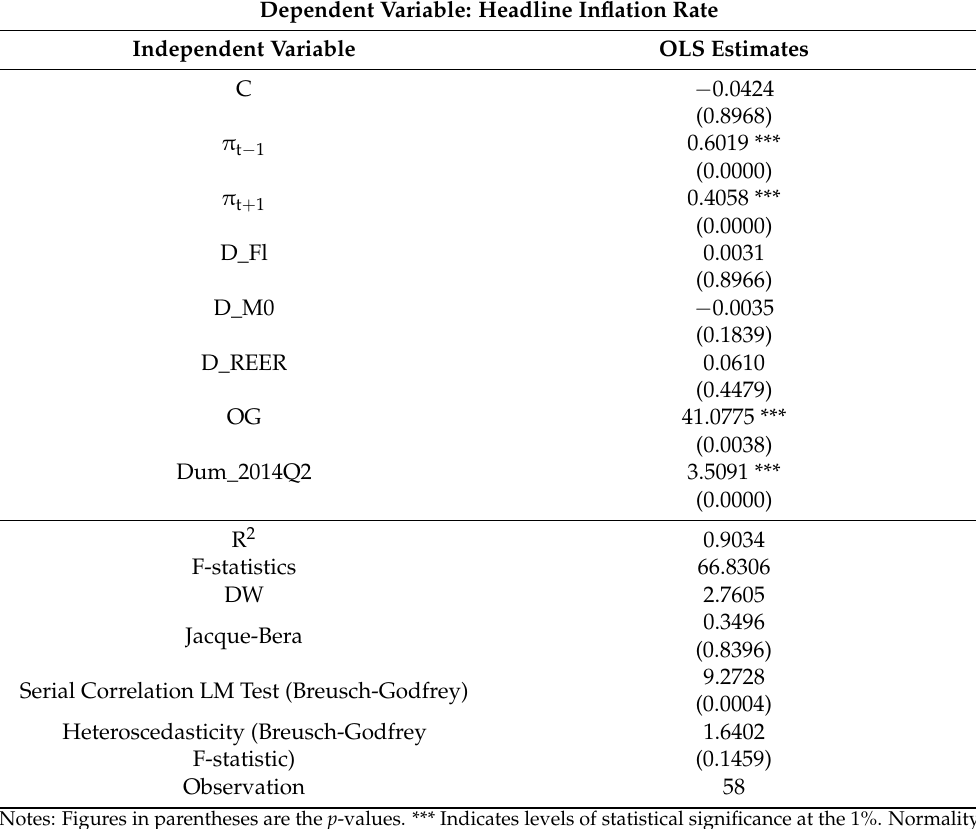
Table A3. OLS estimates and diagnostic test